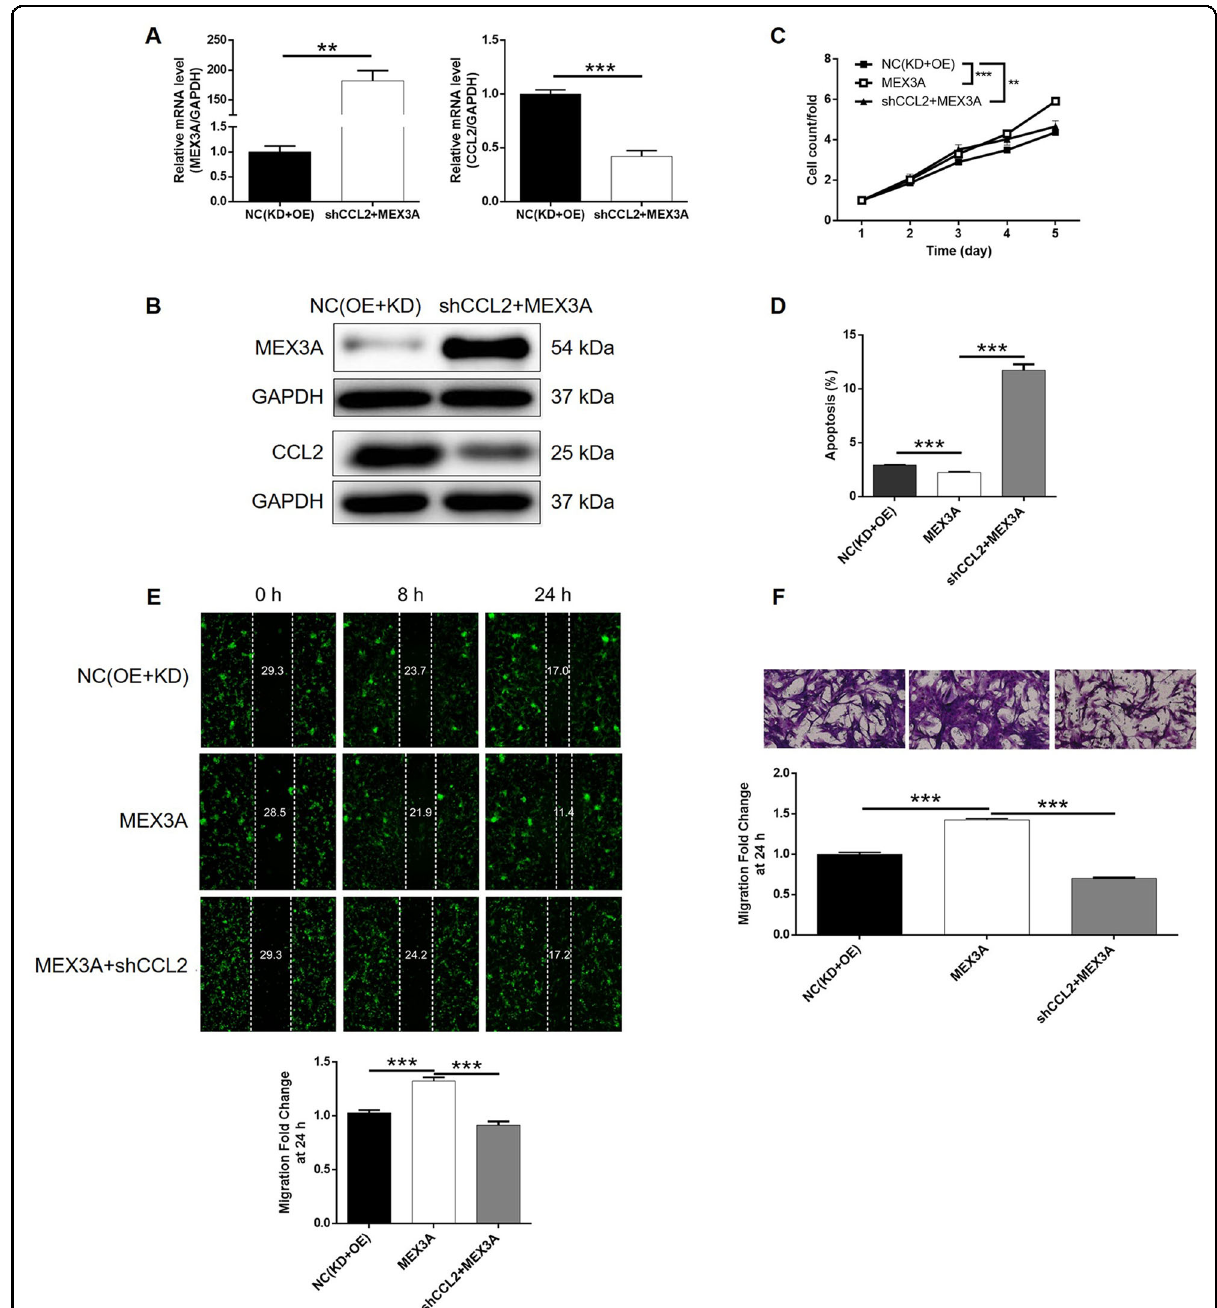
Fig. 6 Knockdown of CCL2 attenuated the effects of glioma cells by MEX3A overexpression. U251 cells transfected with NC(OE + KD), MEX3A- overexpression plasmids, and simultaneous MEX3A-overexpression plasmids, and shCCL2 was subjected to the detection of expression ( A , B ) cell proliferation by Celigo cell counting assay ( C ), cell apoptosis by fl ow cytometry ( D ), cell migration by wound-healing assay ( E ), and cell migration by Transwell assay ( F ). The representative images were selected from at least three independent experiments. Data were shown as mean ± SD. * P < 0.05, ** P < 0.01, *** P <